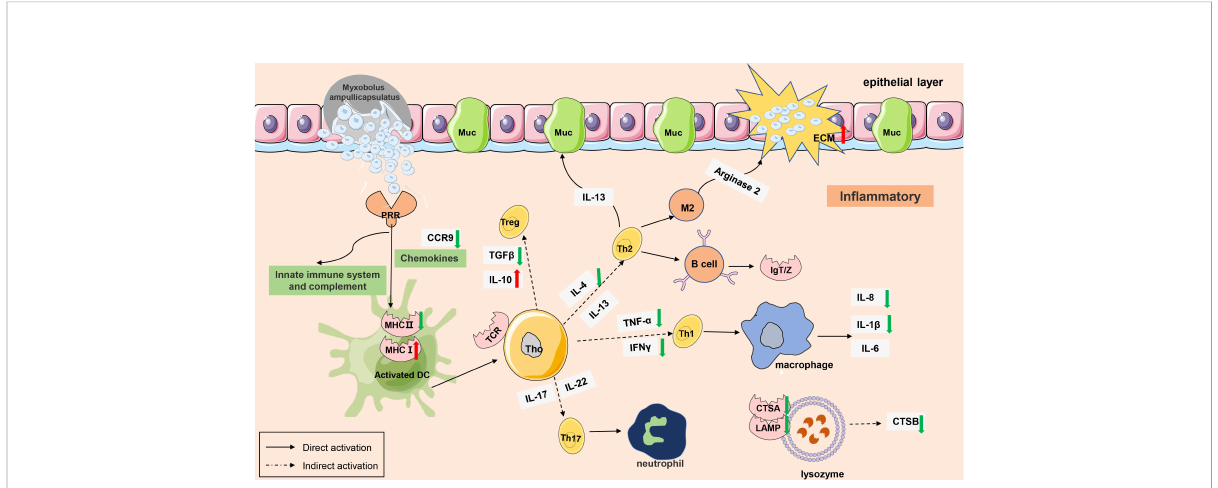
FIGURE 10 A model of immunosuppression in gills of gold fi sh infected with Myxobolus ampullicapsulatus. Schematic diagram showing the main immune- related events involved in gill Myxobolus ampullicapsulatus in gold fi sh inferred from the results of this study. Red arrow represents up- regulation; green arrow represents